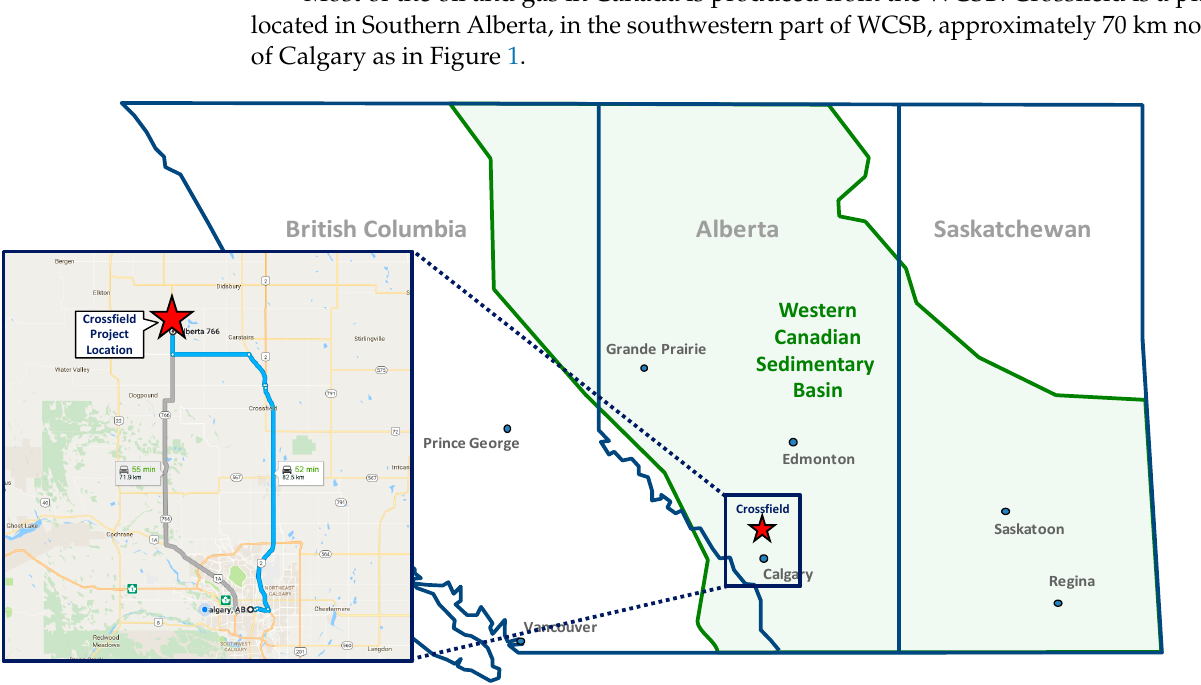
Figure 1. Location of Crossfield in Alberta,